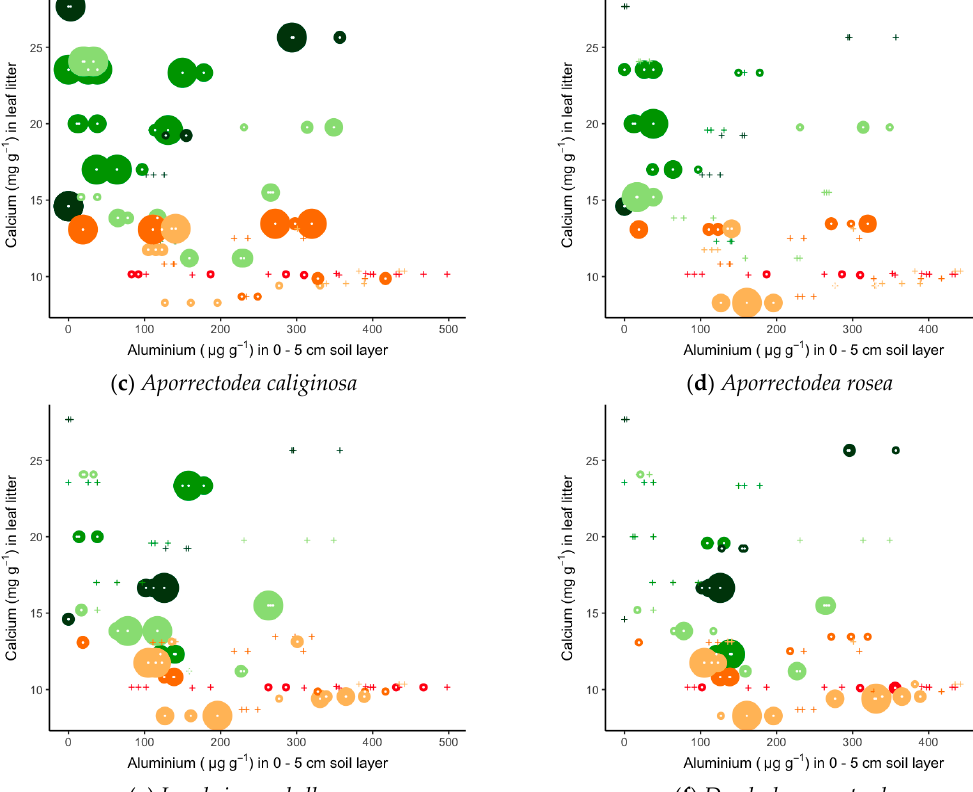
Figure A1. The density of the most common earthworm species (anecic: L. terrestris ( a ) and A. longa ( b ); endogeic: A. caliginosa ( c ); A. rosea ( d ); and epigeic: L. rubellus ( e ) and D. octaedra ( f )) in relation with exchangeable soil Al concentration and Ca concentration in litter. Earthworm density is shown by the size of the circles; a cross symbol indicates plots where no earthworms were found. The color of the circle indicates the tree species. The foliar litter Ca concentration was previously published by Vesterdal et al. [36].